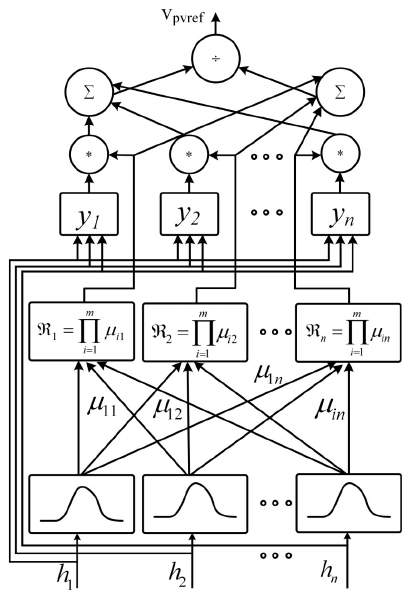
Figure 5. Neuro-fuzzy